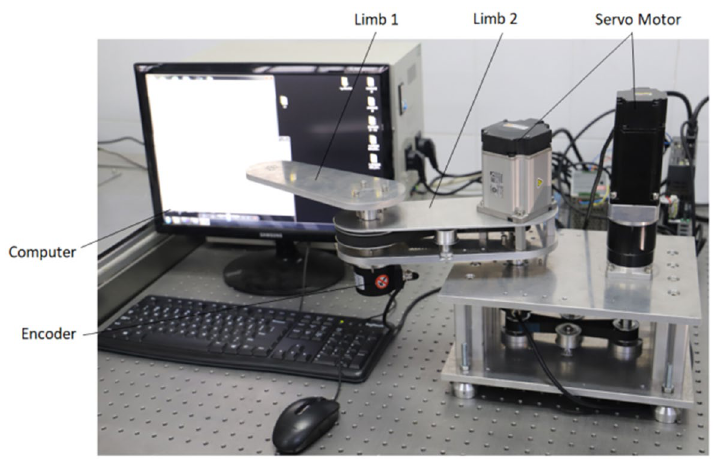
Figure 5. Experiment platform of robot manipulator with two-link.